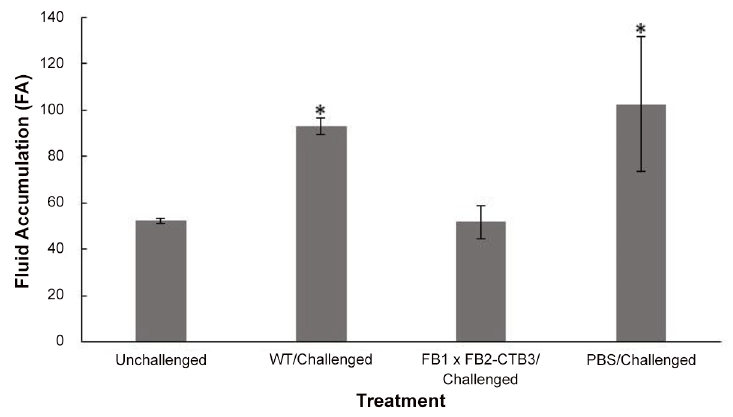
Fig 6. Immunoprotection against CT challenge of BALB/c mice immunized with galls expressing the CTB protein. Mice were immunized with either WT galls or FB1 x FB2-CTB 3 galls, and then challenged